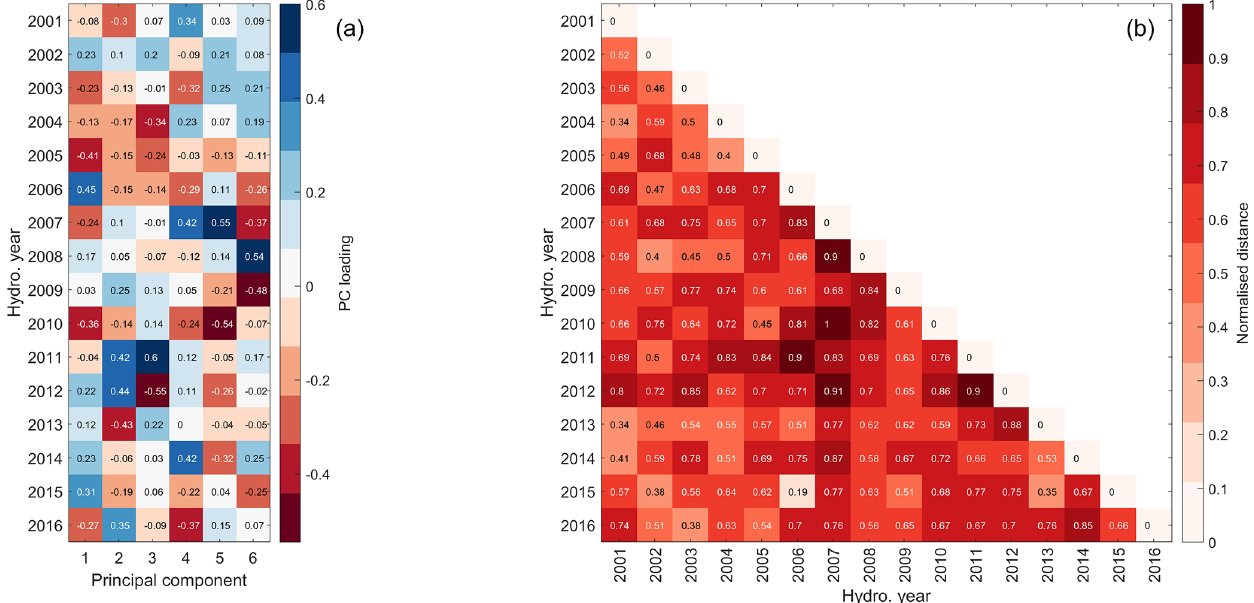
Figure 12. (a) Loadings for the first six principal components of the SCD anomaly (77% of total variance) for each hydrological year (which corresponds with the winter of the preceding calendar year). (b) Normalised distance between PC